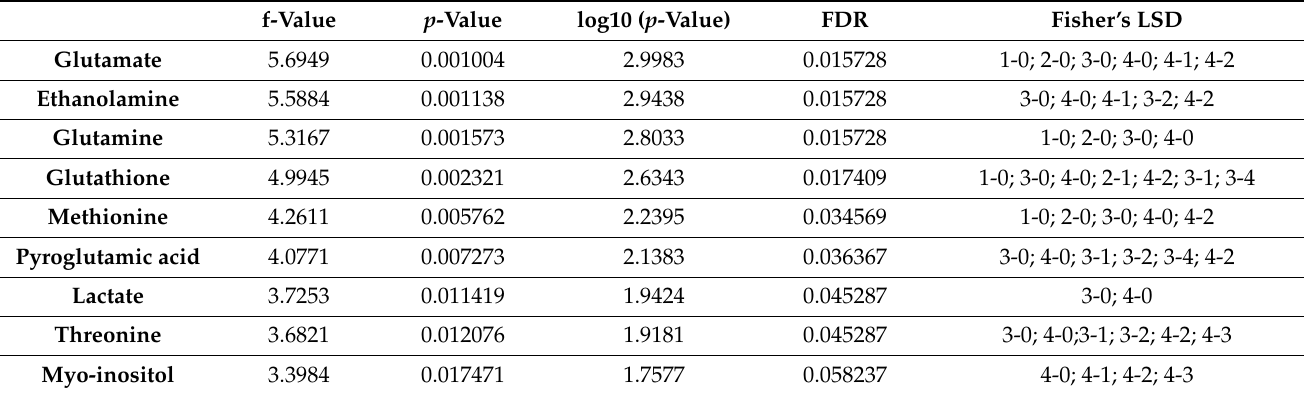
Table 1. The one-way ANOVA results and post hoc test are reported. Healthy control (0), AK I (1), AK II (2), AK III (3) and SCC (4).